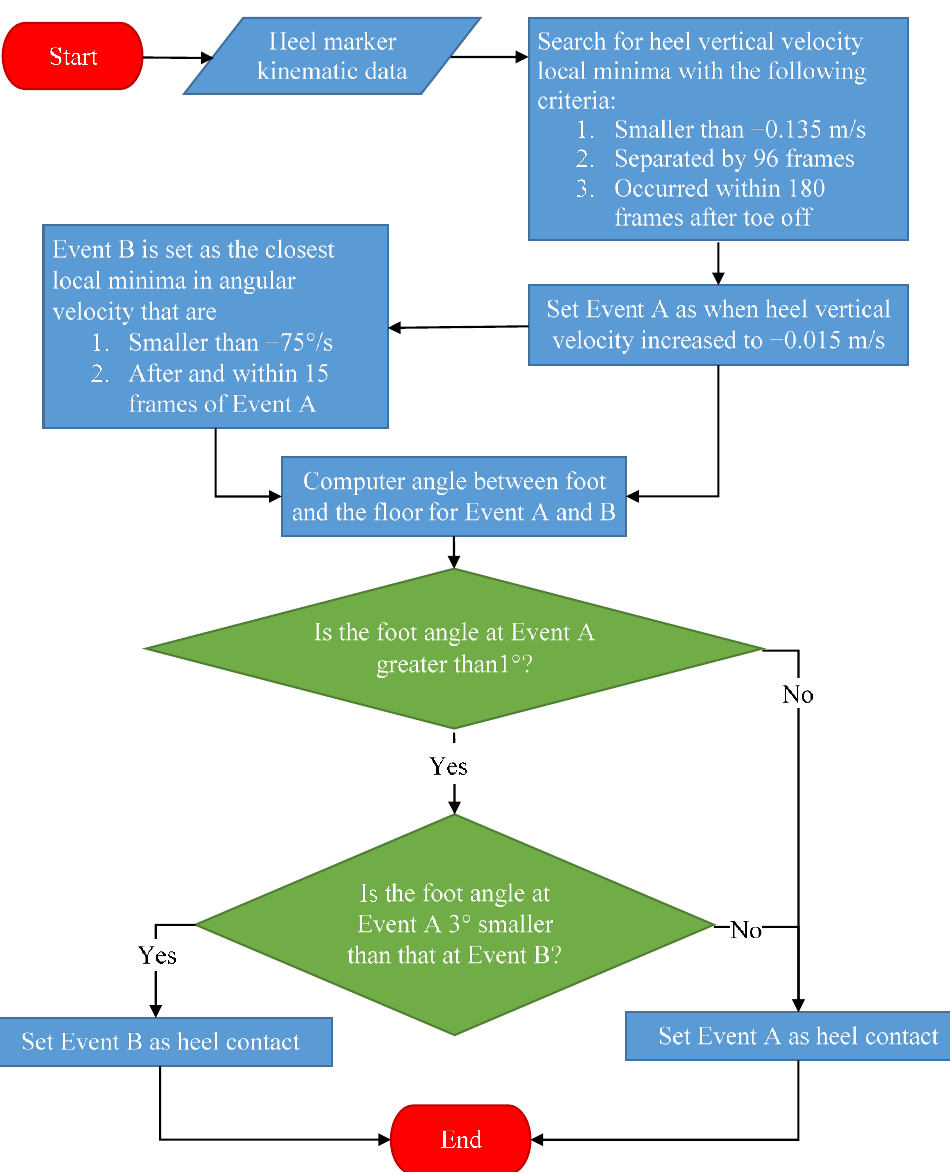
Figure 6. Heel contact event detection process flow